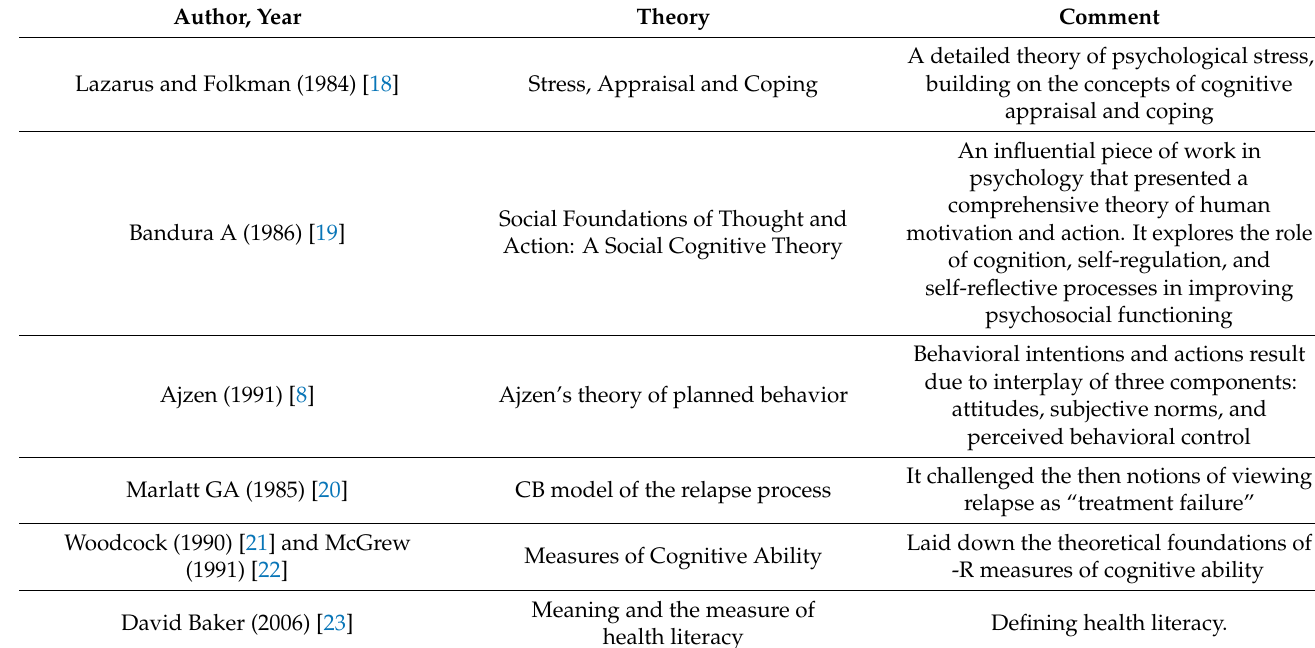
Table 4. Theories in patient education research yielding the highest centrality values ( ≥